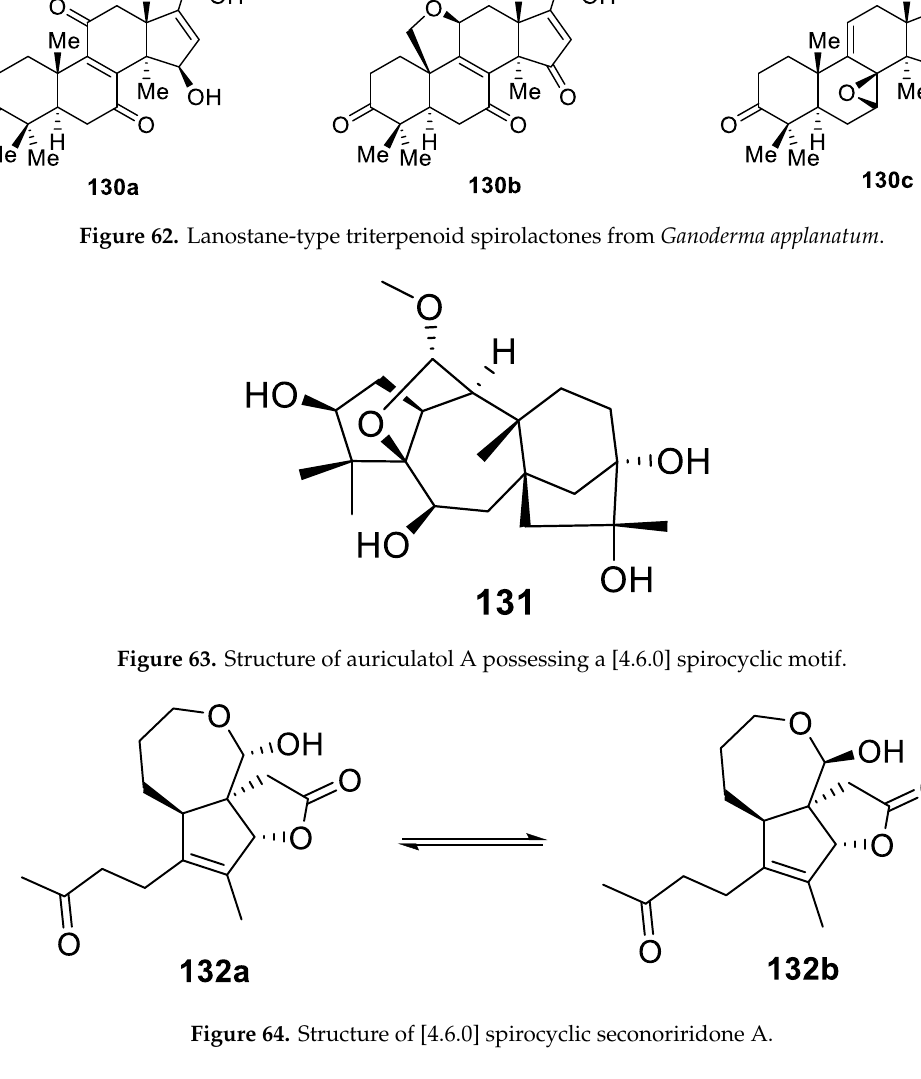
Figure 62. Lanostane-type triterpenoid spirolactones from Ganoderma applanatum .